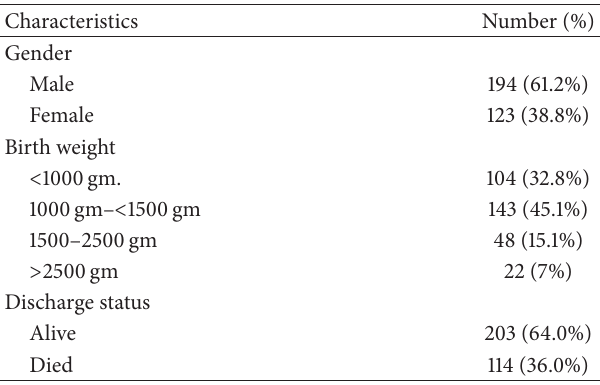
Table 1: General characteristics of the admitted neonates ( 𝑛 = 317) during 6-month